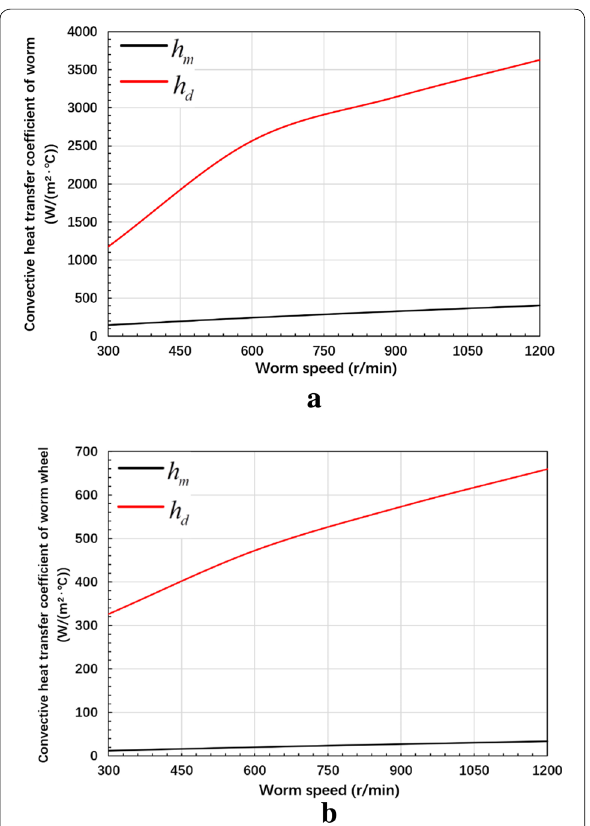
Figure 7 a Convection heat transfer coefficient of the worm, b convective heat transfer coefficient of the worm